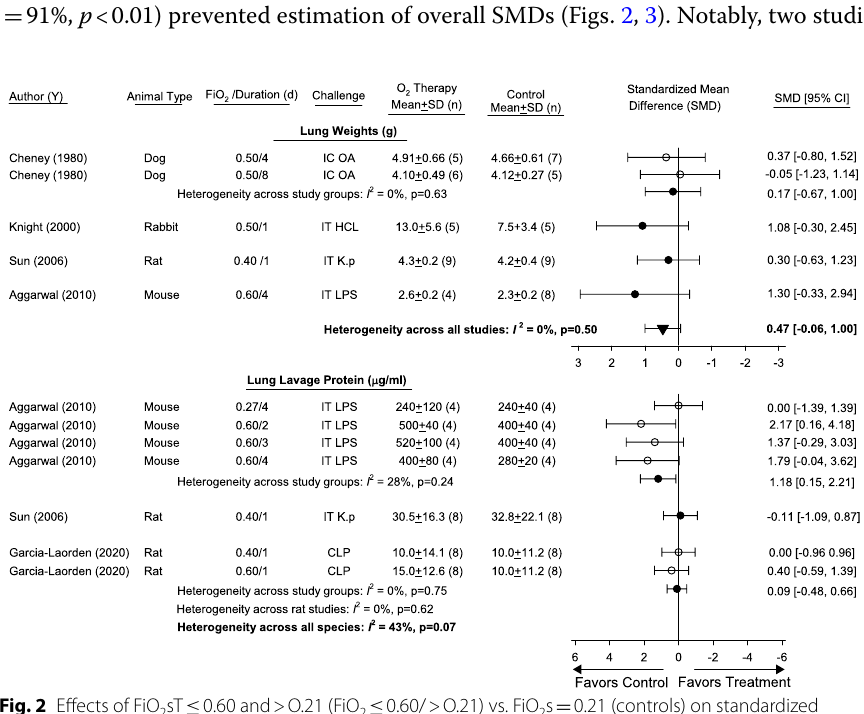
0.60 and > O.21 (FiO 2 ≤